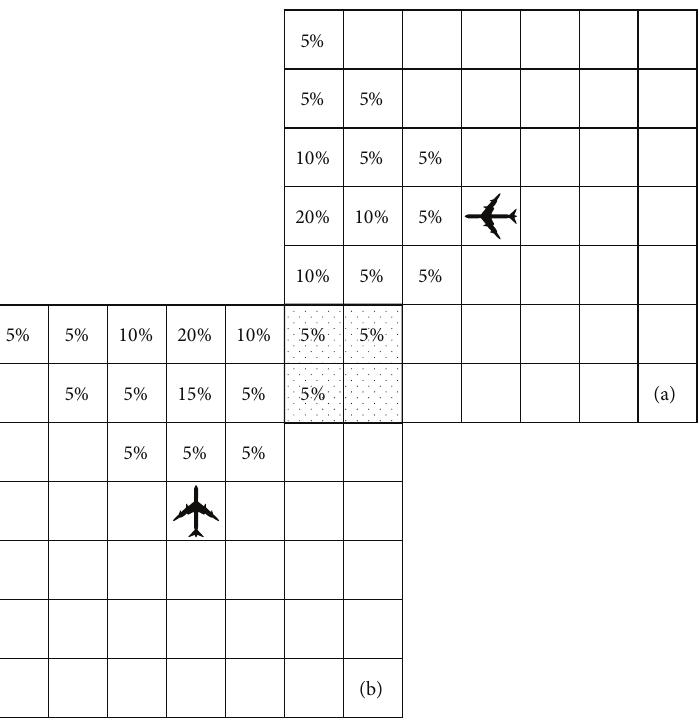
Figure 7: Probability of conflict in time 𝑁